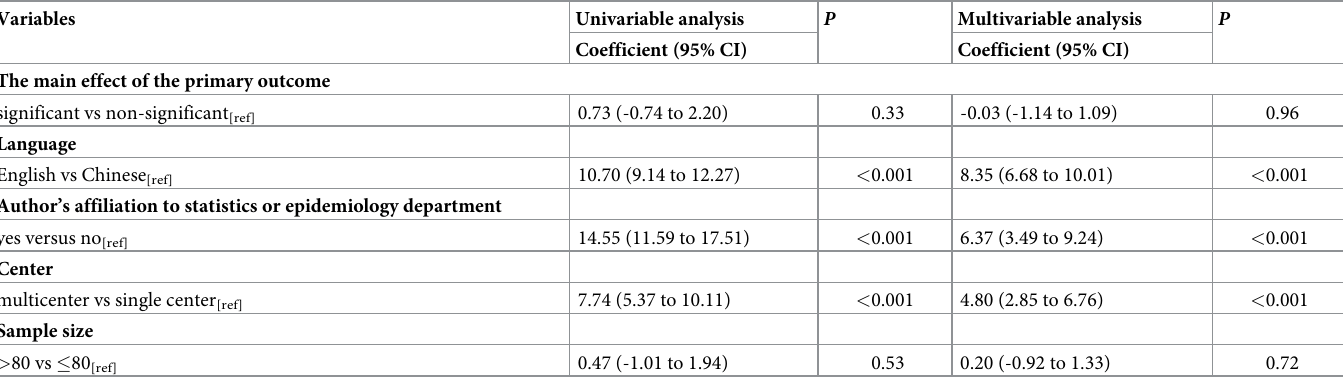
Table 4. Factors associated with overall reporting quality a .